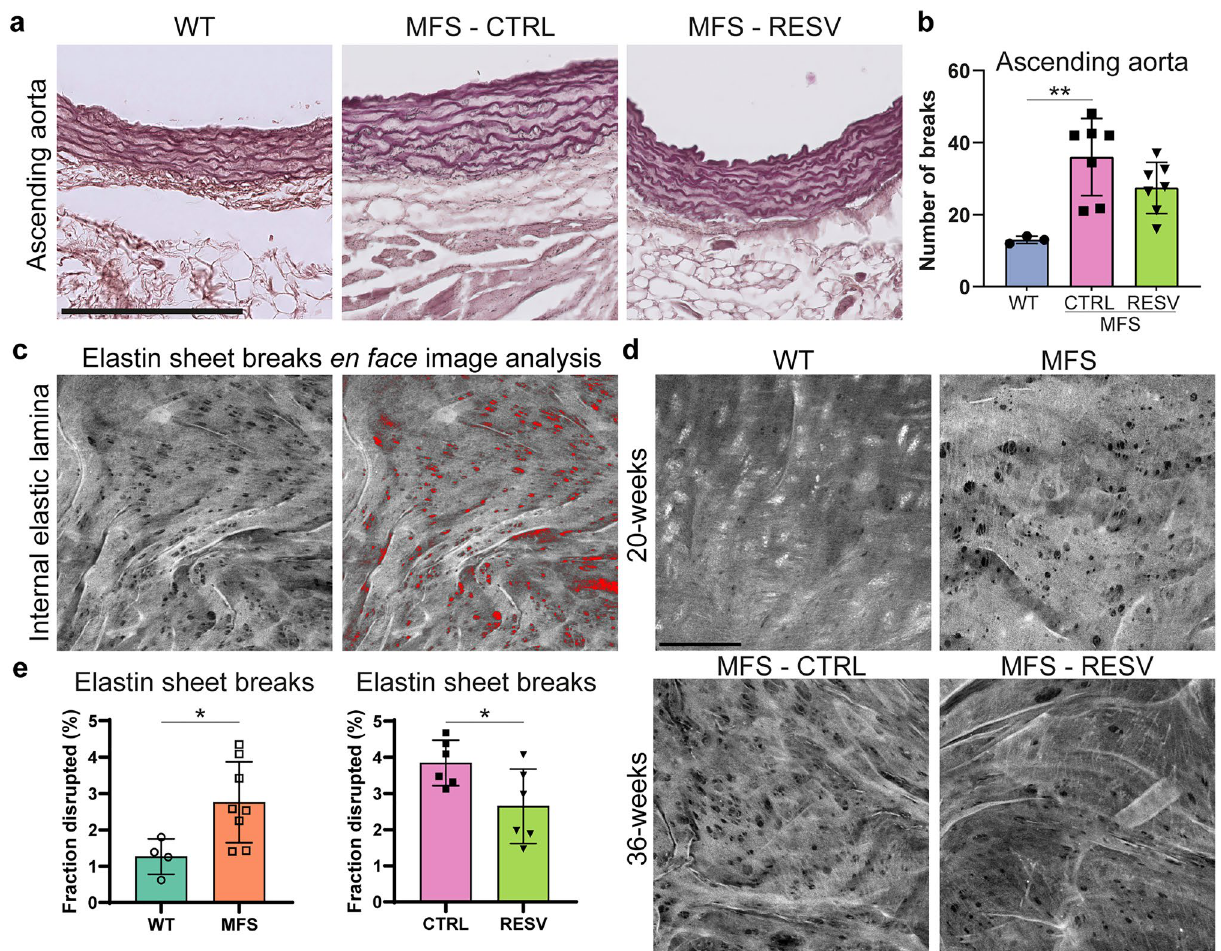
Figure 4. Elastin sheet disruptions in MFS mice are restored by resveratrol treatment. ( a ) Representative images of the elastin lamellae in ascending aorta sections visible after Lawson staining. Scale bar indicates 200 µm. ( b ) Bar plot comparing the number of elastin fiber breaks in the ascending aorta of 36 week old mice. WT (N = 3; M/F 0/3) n = 9 images, MFS-CTRL (N = 7; M/F 0/7) n = 21 images, and MFS-RESV (N = 7 M/F 0/7) n = 21 images. ( c ) Image analysis of autofluorescent internal elastic lamina (IEL) captured by en face confocal imaging. Wavy elastin lamellae with fenestrae are shown in maximal projection. Quantification of the disrupted area (in red) is performed and presented as percentage of the total elastin area. ( d ) Representative images of IEL in 20 weeks old WT and Fbn1 C1041G/+ MFS mice in top panel, and of 36 weeks MFS-CTRL and MFS-RESV in the bottom panel. Scale bar indicates 50 µm ( e ) Bar plot comparing the fraction of disrupted IEL in WT WT (N = 4; M/F 0/4) n = 12 images versus MFS (N = 8; M/F 0/8) n = 25 images (left) and MFS-CTRL (N = 6 M/F 0/6) n = 23 images versus MFS-RESV (N = 6 M/F 0/6) n = 22 images (right). All quantified data represents mean ± SD with indicated data dicular over the cell junction. Background values were subtracted and normalized values were used to calculate peak height and AUC using Graphpad Prism 9.1 (La Jolla, CA, USA).